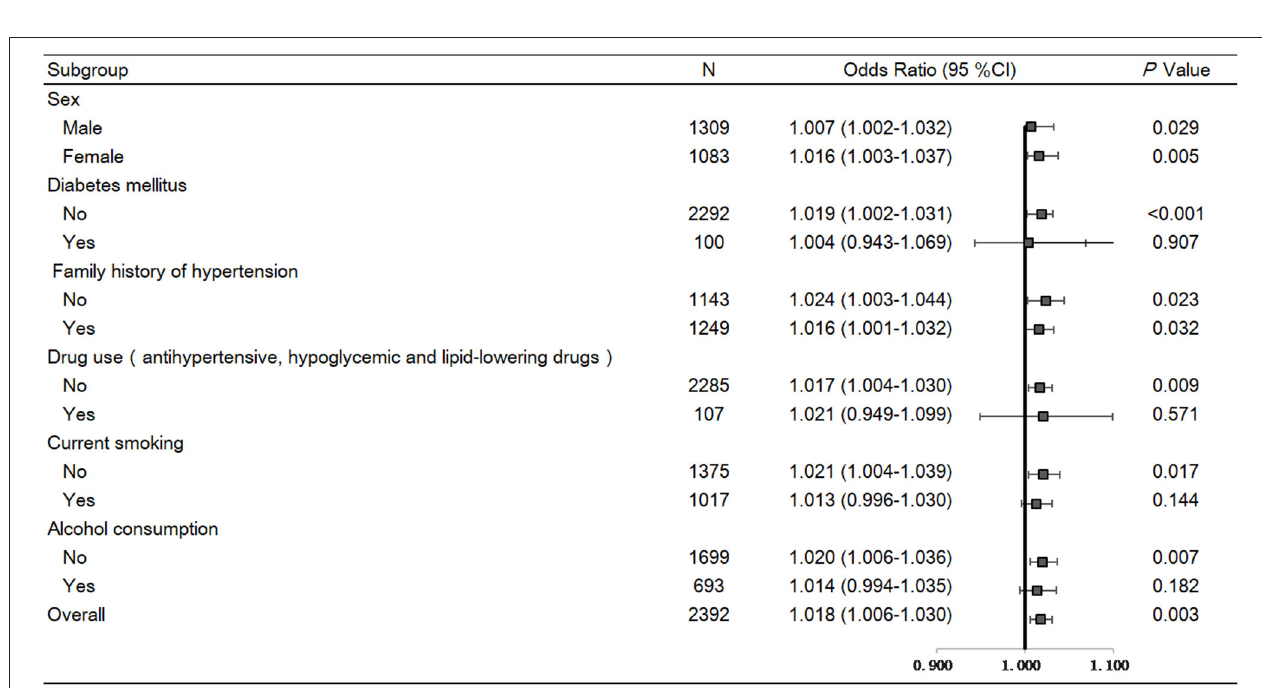
FIGURE 1 | Associations of serum renalase with BP levels and hypertension. (A) Serum renalase levels in subjects with normotension and hypertension. (B) Serum renalase levels in subjects with different grades of BP, including normotension, high-normal, grade 1 and grade 2 hypertension. (C) Serum renalase levels in subjects with normotension and different hypertensive subtypes, including ISH, IDH, SDH. The differences between two groups were analyzed by Student’s t -test, and analysis of variance (ANOVA) was used to test the linearity across different grades and subtypes of hypertension. BP, blood pressure; ISH, isolated systolic hypertension; IDH, isolated diastolic hypertension; SDH, systolic diastolic hypertension.